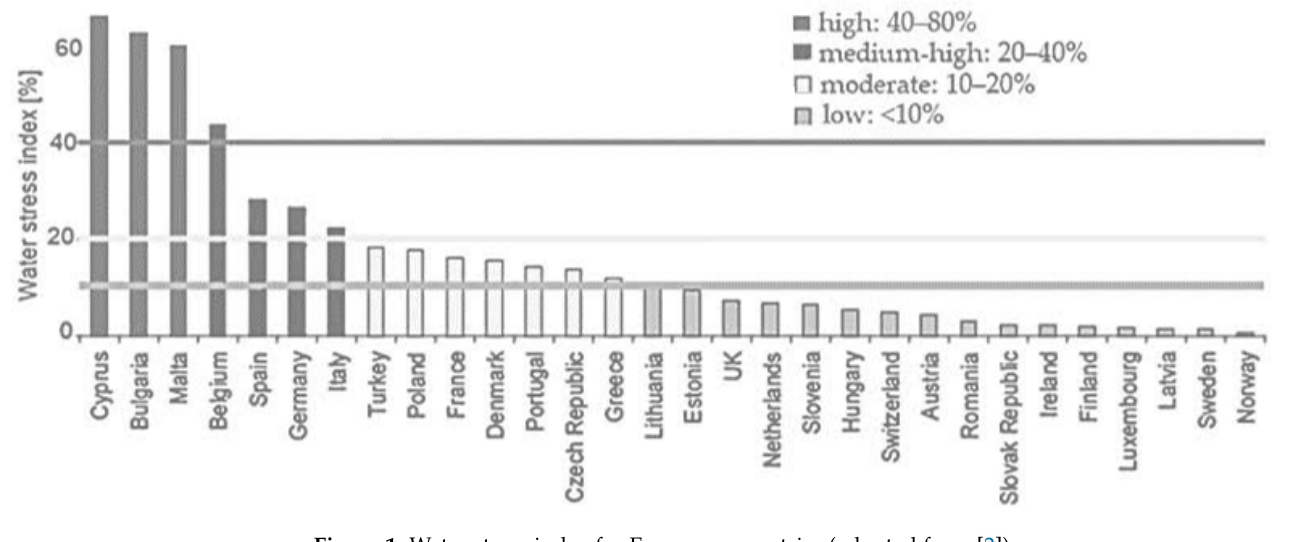
Figure 1. Water stress index for European countries (adapted from [2]). Arid areas are affected by water